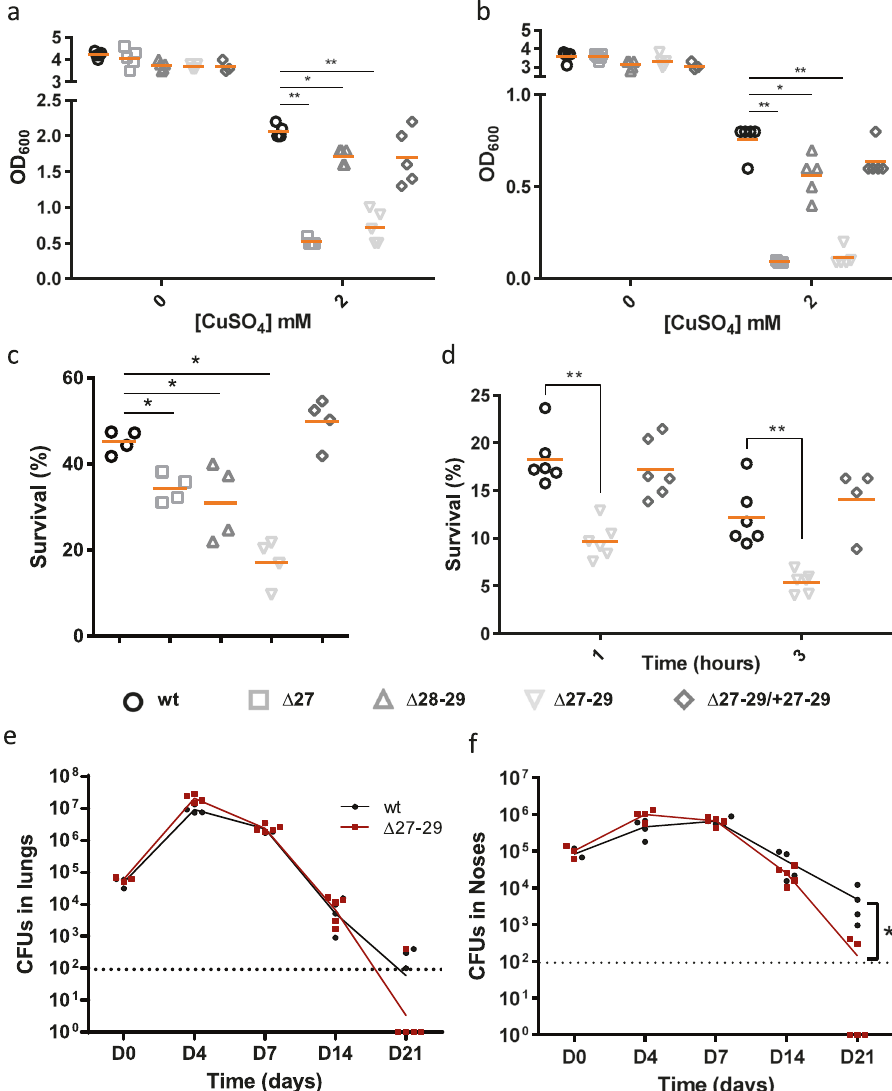
Fig. 4 Role of the operon in B. pertussis and in host – pathogen interactions. a , b Growth yields of B. pertussis after 24 h in SS medium ( a ) or in SS medium devoid of glutathione ( b ), supplemented or not with 2 mM CuSO 4 . The cultures were inoculated at initial OD 600 values of 0.1, and after 24 h the OD 600 was determined. Note the different y axis scales between ( a ) and ( b ). wt, wild type (parental) strain; Δ 27, Δ 28-29 and Δ 27-29, KO mutants for bp1727 ( copZ ), bp1728 - bp1729 ( prxgrx-gorB ) and the three genes, respectively. The various strains are represented using different symbols and shades of gray. Δ 27-29/ + 27-29 represents the latter mutant complemented by expression of the operon at another chromosomal locus. The horizontal orange lines represent mean values. c Survival of the same strains to an oxidative shock of 30 min. d Intracellular survival of B. pertussis in THP1 macrophages. The horizontal orange lines represent mean values. See Supplementary Figure S6 for the data of the individual copZ and prxgrx-gorB KO mutants. e , f Colonization of mice lungs ( e ) and nasopharynxes ( f ) after nasal infections with the parental strain and the copZ-prxgrx-gorB KO mutant. The numbers of bacteria are indicated for each mouse and organ (black circles: parental bacteria, red squares: mutant). The lines connect the geometric means of the counts at each time point, and the dotted lines indicate the thresholds of detection. For all the assays, statistical analyses were performed using two-tailed Mann-Whitney tests ( *, p < 0.05; ** p, <0.005 ). For panels a and b , 5 biologically independent samples were used. For panels c and d , 4 and 6 biological samples were used, respectively. For panels e and f , 5 and 4 animals per time point were used for the KO and wt strains,